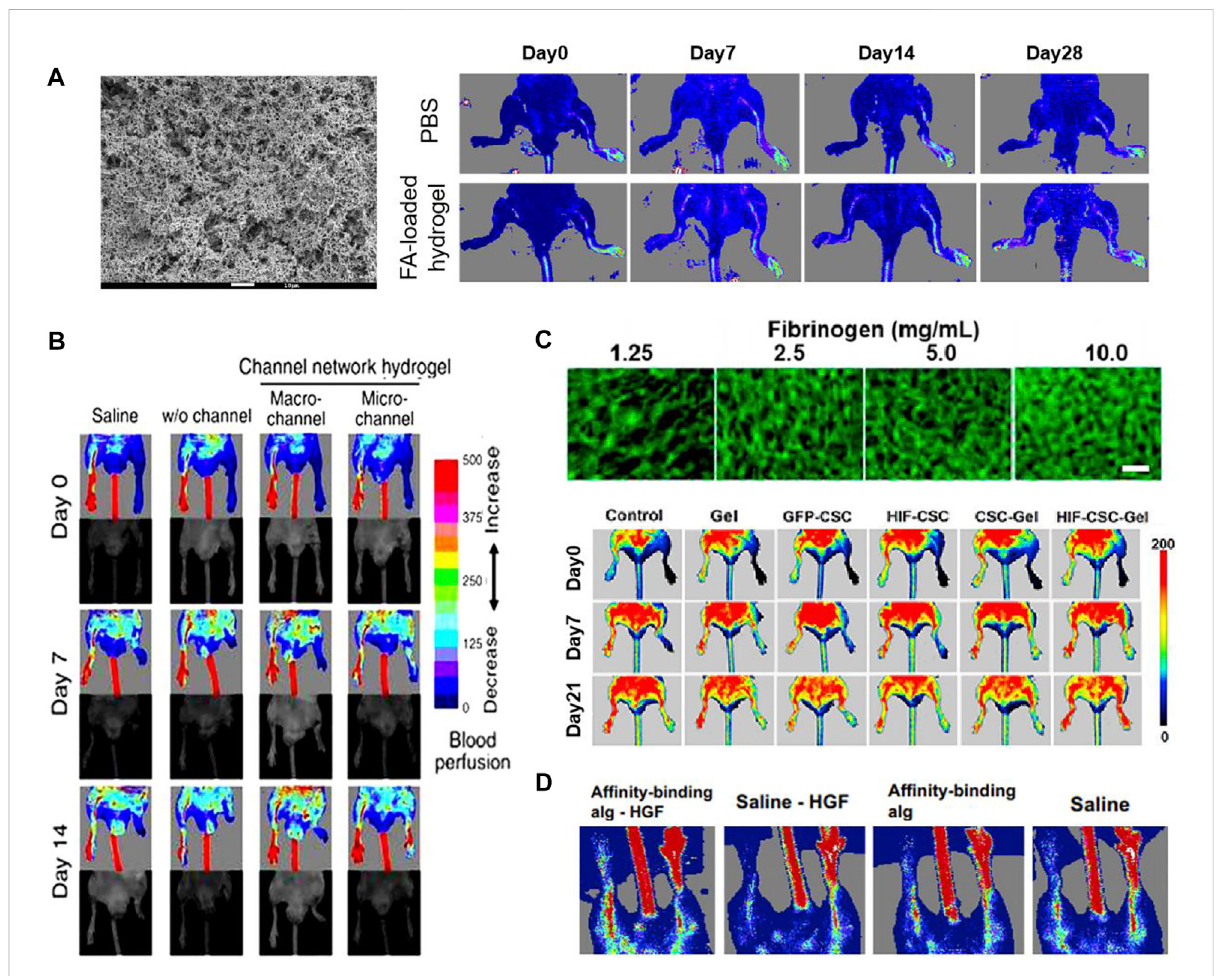
FIGURE 7 Schematic diagrams of several natural hydrogels to improve angiogenesis. (A) The SEM image of the FA-chitosan hydrogel and the result of animalstudytopromoteangiogenesis.Scalebar=10 μ m. (B) LDPIimagesinahindlimbischemiamousemodel. (C) Confocalmicroscopyimagesof amicro-architectureofinjectable fi brinhydrogelwithdifferentconcentrationsof fi brinogensolutionandtherepresentativeLDPIimages.Scalebar= 50 μ m. (D) LDPI images proved the angiogenesis effect of the HGF-alginate hydrogel. (A) is reprinted with permission from ref. (Wang et